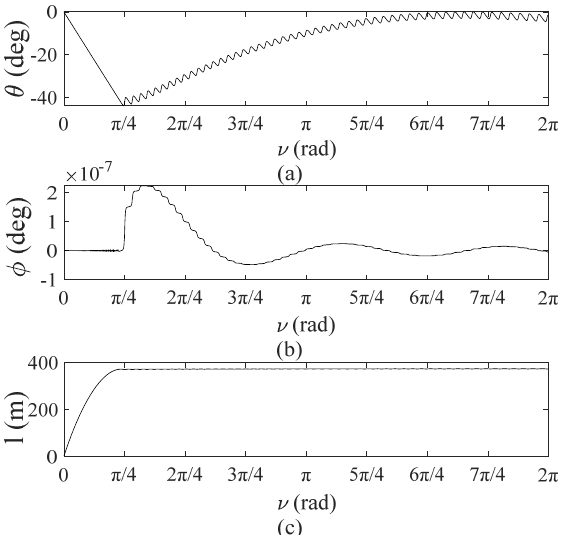
Figure 8. Deployment process of TSS: ( a ) tether in-plane angles versus ν ; ( b ) tether out-plane vibration angles versus ν ; ( c ) tether length versus ν .